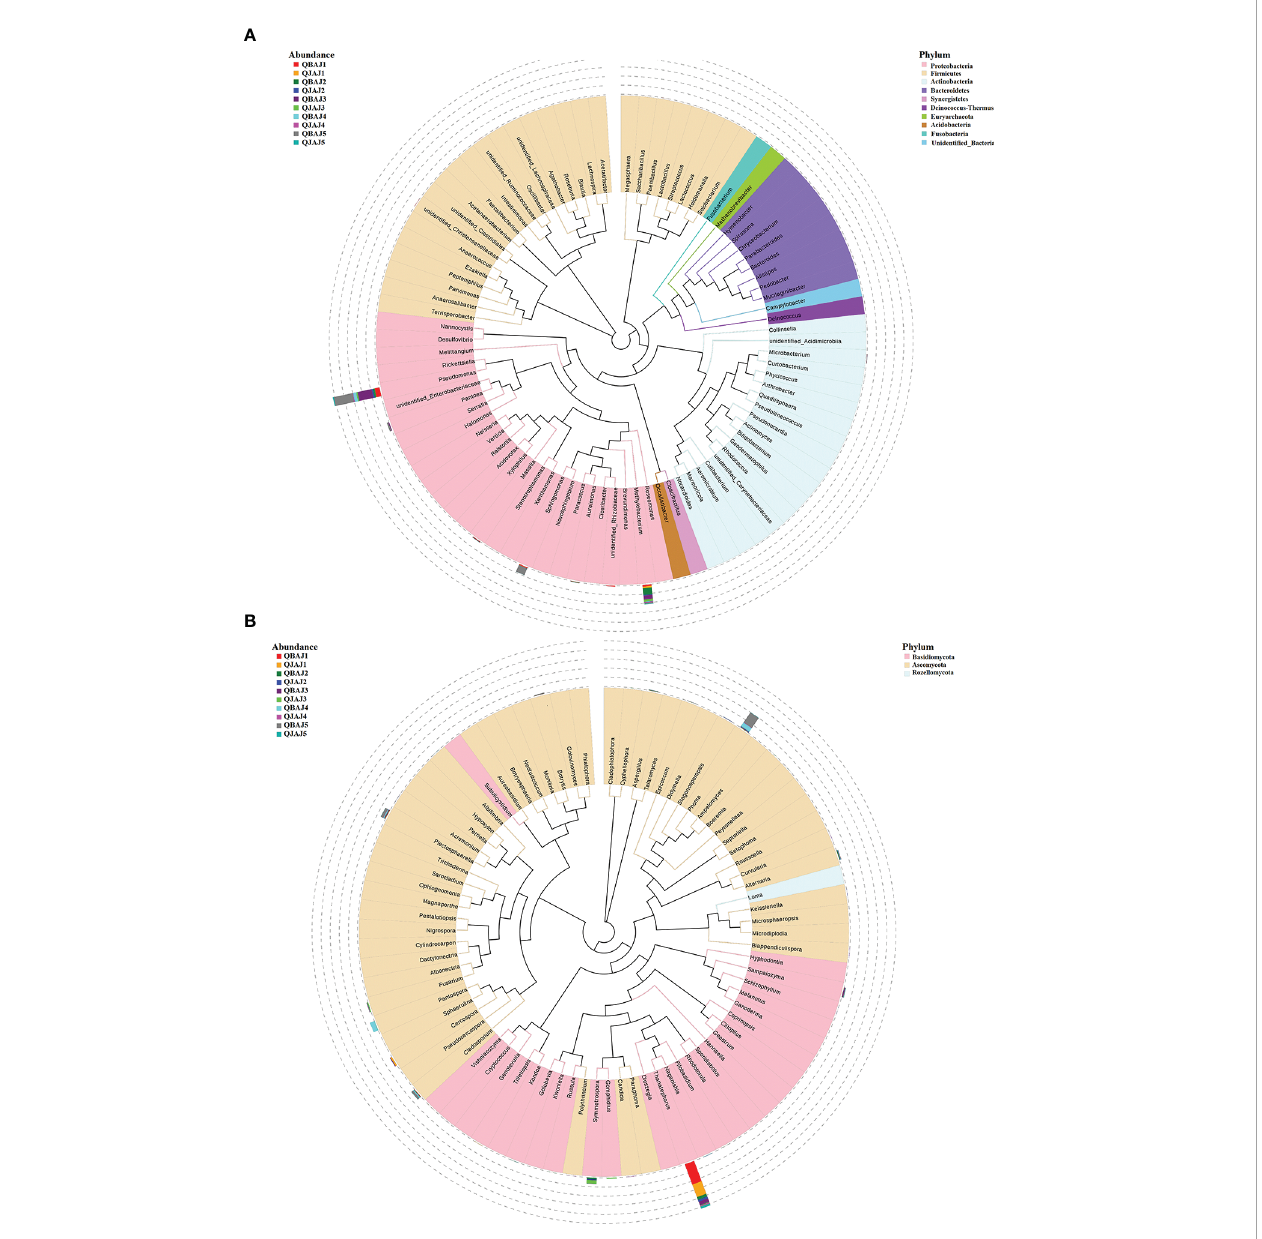
FIGURE 3 Maximum likelihood tree of the 100 most abundant bacterial (A) and fungal (B) genera in the ten group samples from tobacco leaves infected with target spot, obtained by analysis of 16S rRNA and ITS rDNA pyrosequencing data. A color-coded bar plot shows the distribution of each fungal and bacterial genus in different